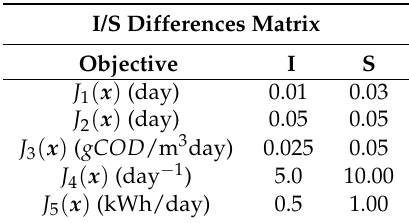
Table 6. Matrix with (in) significant differences for MOP statement I. Significant (S) and Insignificant (I) differences for each design objectives are